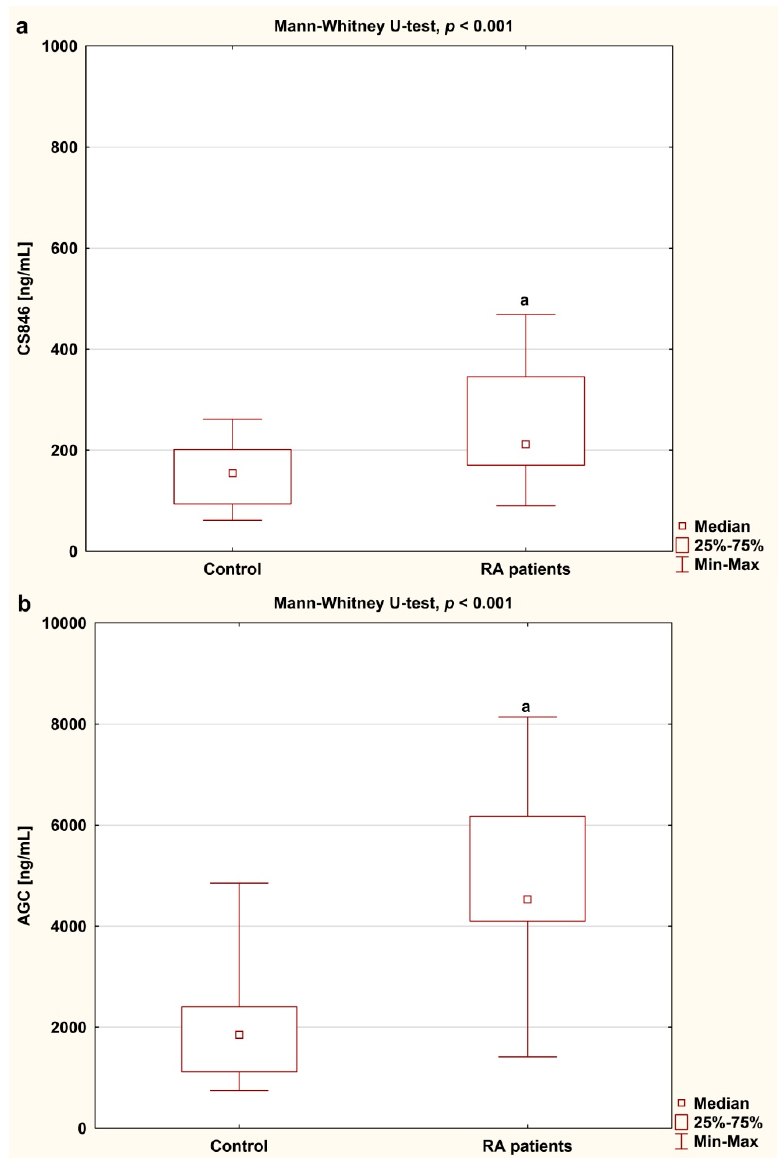
Figure 2. Serum levels of CS846 ( a ) and AGC ( b ) in RA patients before anti-TNF- α therapy and in controls. Results expressed as median and interquartile (25th–75th percentile) range. Data analyzed using Mann–Whitney U test. a statistically significant di ff erences compared to controls. AGC, aggrecan fragments; anti-TNF- α , anti-tumor necrosis factor α ; CS846, chondroitin sulfate epitope 846; RA, rheumatoid